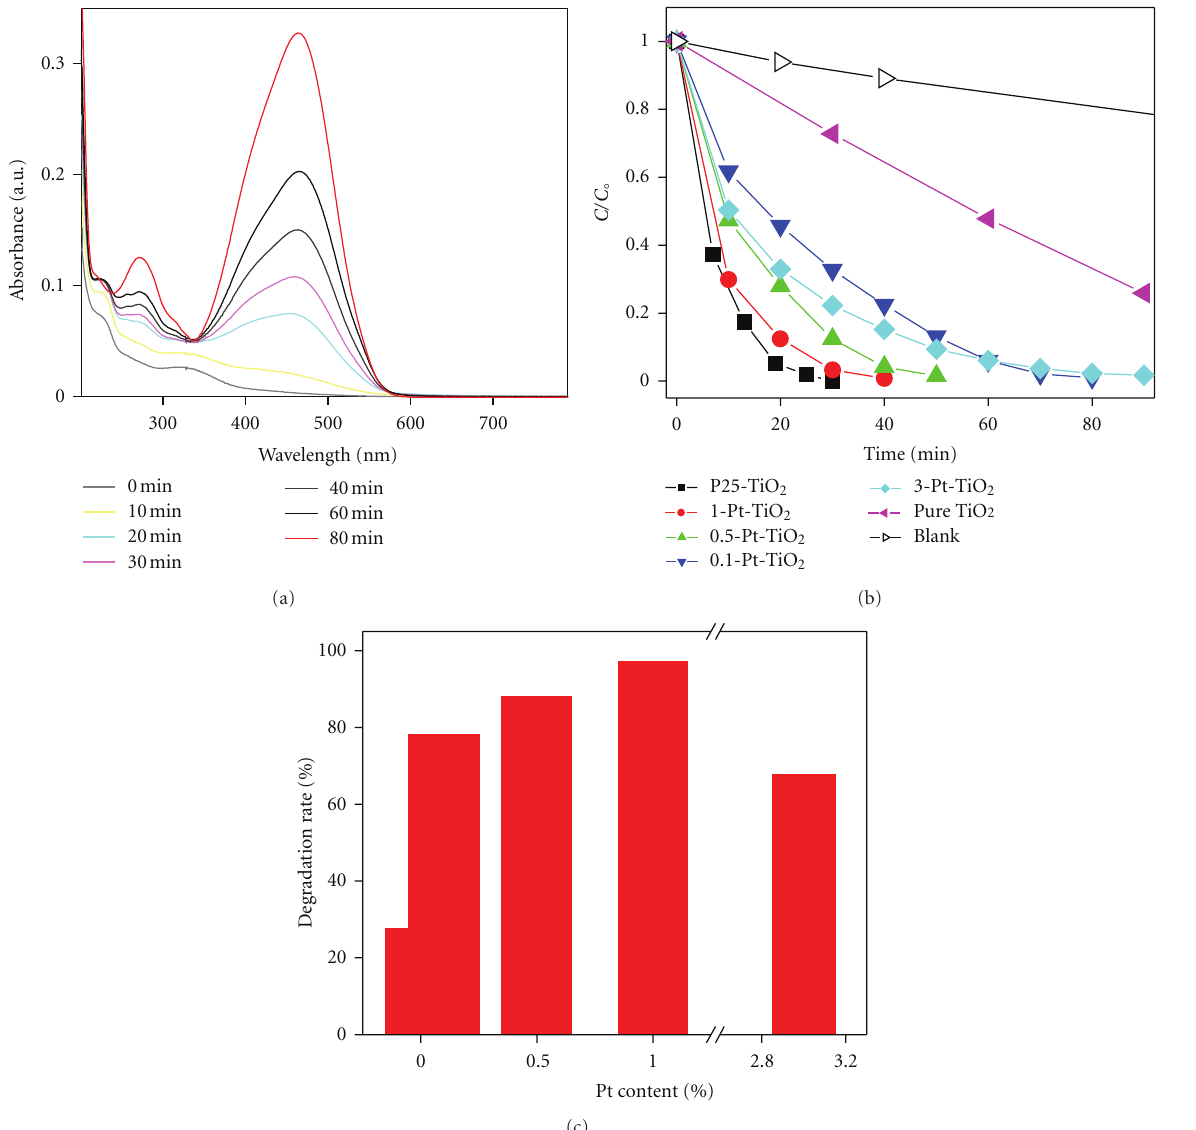
Figure 4: (a) Typical time-dependent absorption spectra of MO solution in the presence of 3.0-Pt-TiO 2 under ultraviolet light irradiation; (b) C / C 0 as a function of irradiating time of MO solution for di ff erent samples in 90min under UV light irradiation; (c) degradation rate for di ff erent Pt loading content of TiO 2 after irradiation for 30min under UV light with a wavelength of 254 nm irradiation. The photocatalytic performances of PureTiO 2 and commercial P25-TiO 2 were measured in the same conditions for